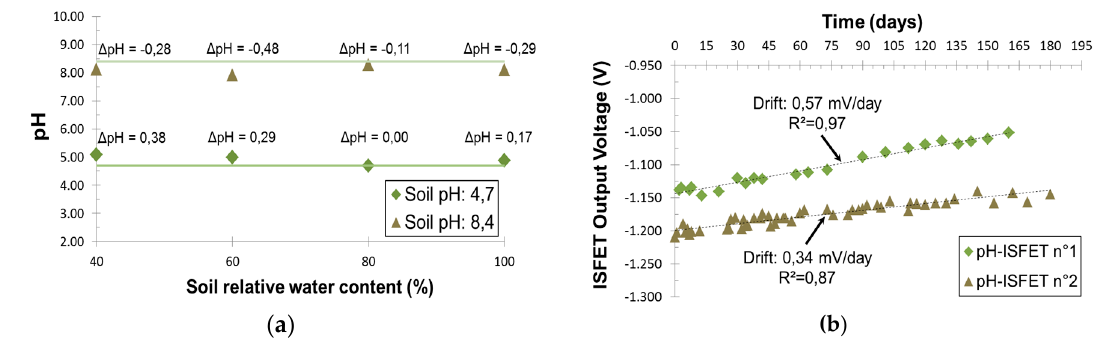
Figure 2. ( a ) Comparison of pH measurements performed by pH-ISFET at different soil moisture levels in an acid and a basic silty-clay soil. The difference with the standard method of soil pH determination (green lines) is indicated above each measurement point; ( b ) Time evolution of the output voltage of two pH-ISFET inserted in a silty-clay soil for six months.